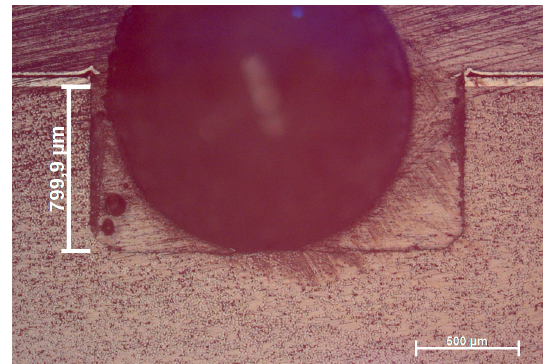
Figure 15. Cross-sectional microstructure of one drilled hole on the CFRP side in the hybrid sample (a large black hole was induced by an air bubble in the resin induced in the embedding process of the sample for analysis).